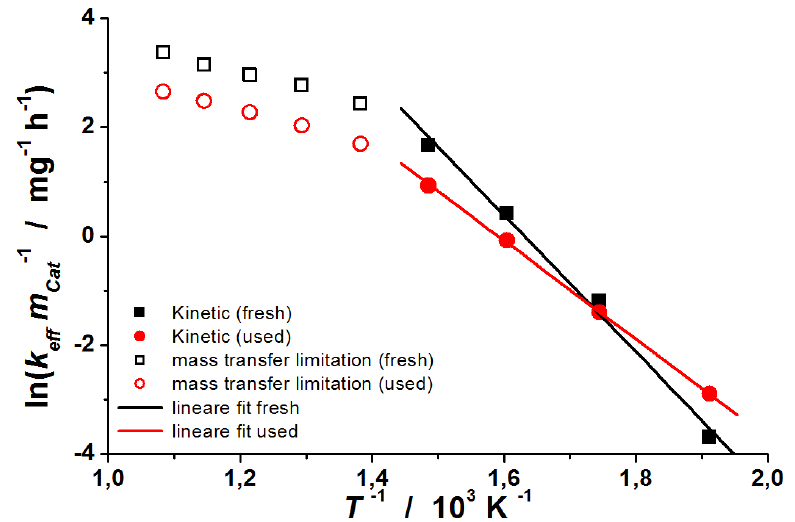
Figure 13. Arrhenius plots of honeycomb catalysts (fresh and